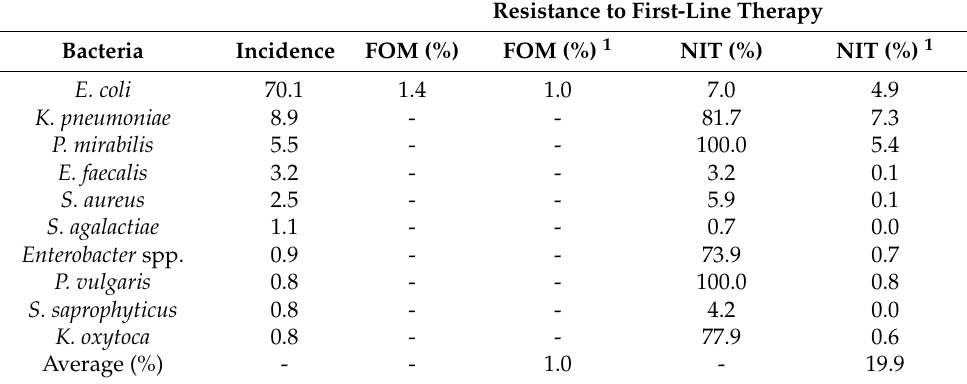
Figure 3. Variation in the antimicrobial resistance patterns of Gram-positive bacteria during the study period. G, generation. Table 4. Calculated bacterial resistance to the antimicrobials recommended as first-line therapy for empirical treatment of UTI.